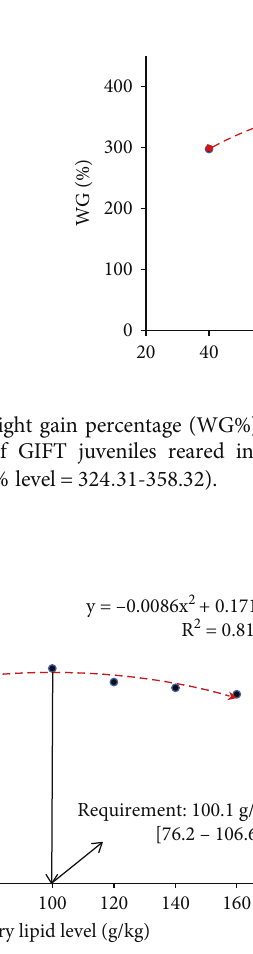
Figure 2: In relation to speci fi c growth rate (SGR, %/day), second order polynomial regression model indicates the optimum dietary crude lipid requirement (g/kg) of GIFT juveniles reared in IGSW = 59 : 37 , p = < 0 : 001 , of 15ppt for 60 days (ANOVA: F 6,14 con fi dence interval, CI for mean at 95% level = 2 : 41